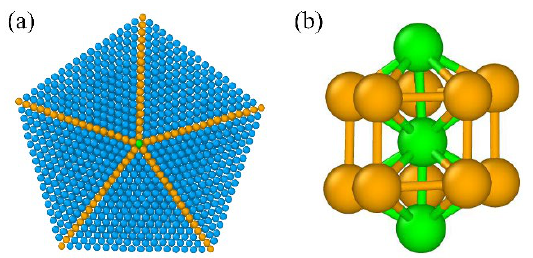
Figure 1. ( a ) Top view of the initial penta-twinned structure. ( b ) Truncated decahedron structures (TDH) colored green. The FCC structures are colored blue, and the HCP structures are colored or- ange.